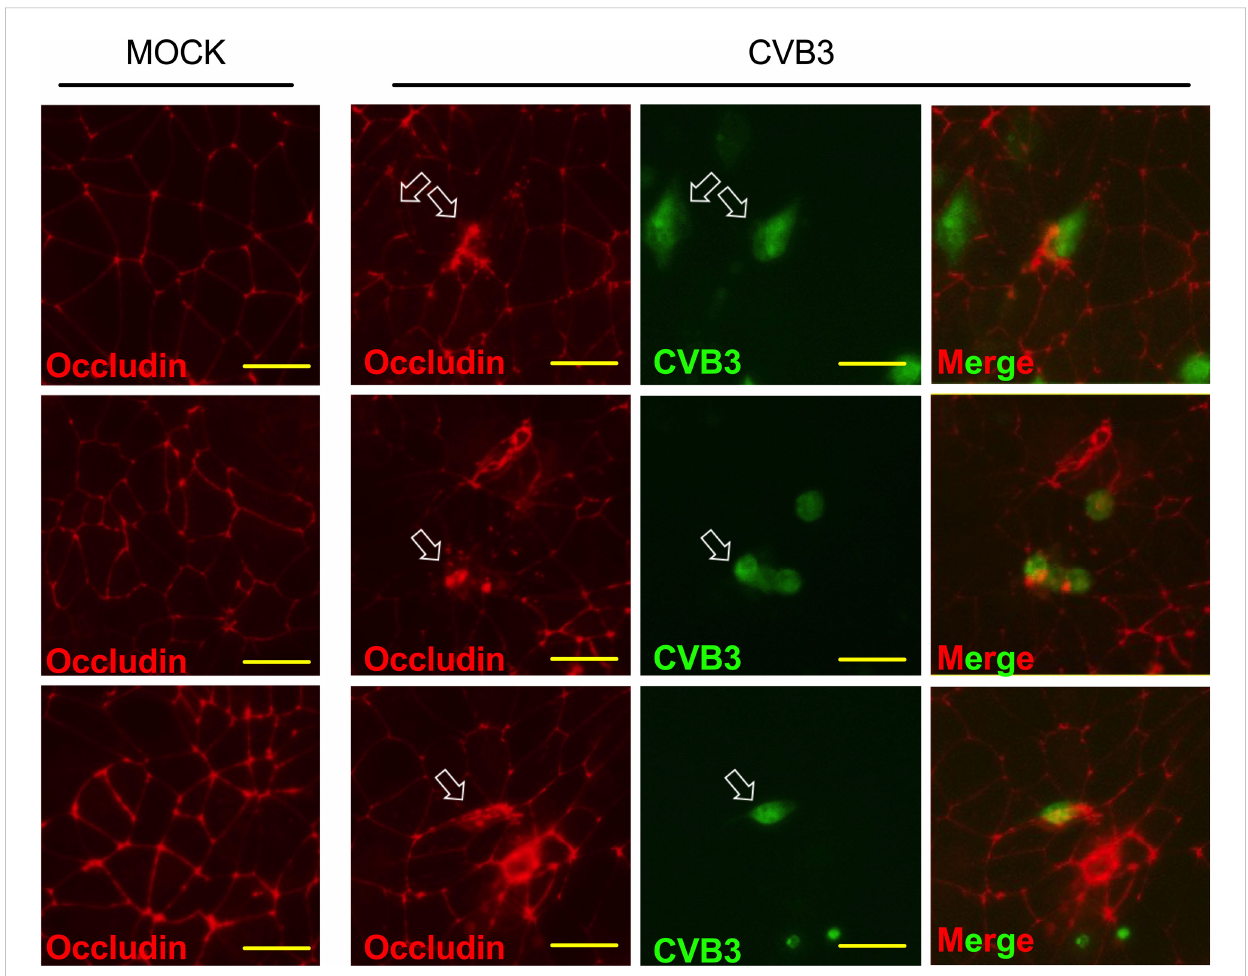
FIGURE 2 Infected iBECs display signs of tight junction disruption. Immunostaining detecting Occludin localization in iBECs either infected with eGFP-CVB3 at MOI 10 or mock treated with equivalent volume DMEM for 72 h. Empty white arrows indicate disrupted Occludin distribution. For eGFP-CVB infected cells, viral eGFP expression is shown to the right. Merged images are of infected cells with eGFP overlayed over Alexa Fluor 594 Occludin. Three representative images are shown for mock and CVB3 infected. Scale bars= 50